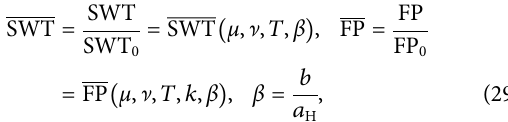
Frontiers in Mechanical Engineering |